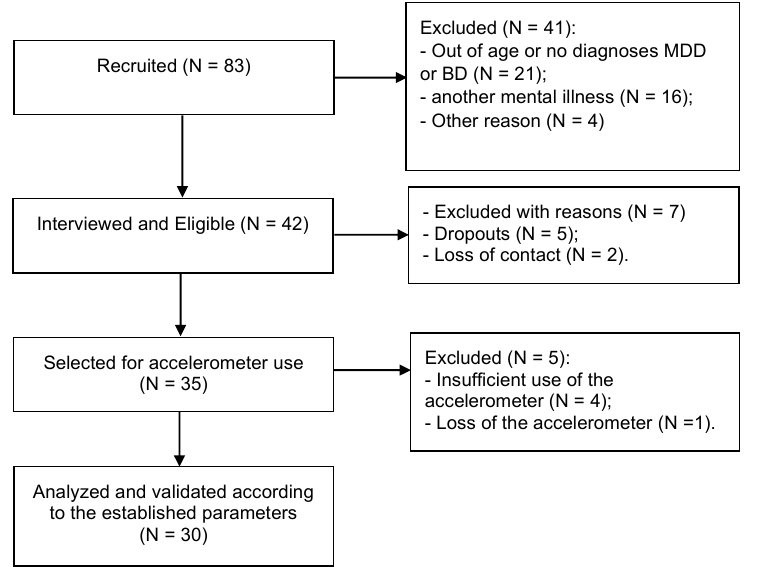
Figure 1. Study flowchart. Table 1. Sample